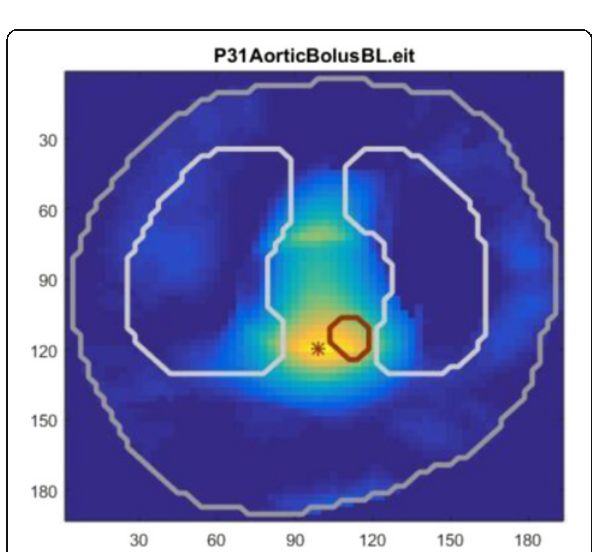
Fig. 121 (abstract A314). Examplary EIT image with superimposed CT-derived outer contours of thorax and lungs. The red circle marks the location of the aorta according to CT. The red asterisk indicates the location of aorta as detected by EIT using a bolus of hypertonic saline as contrast